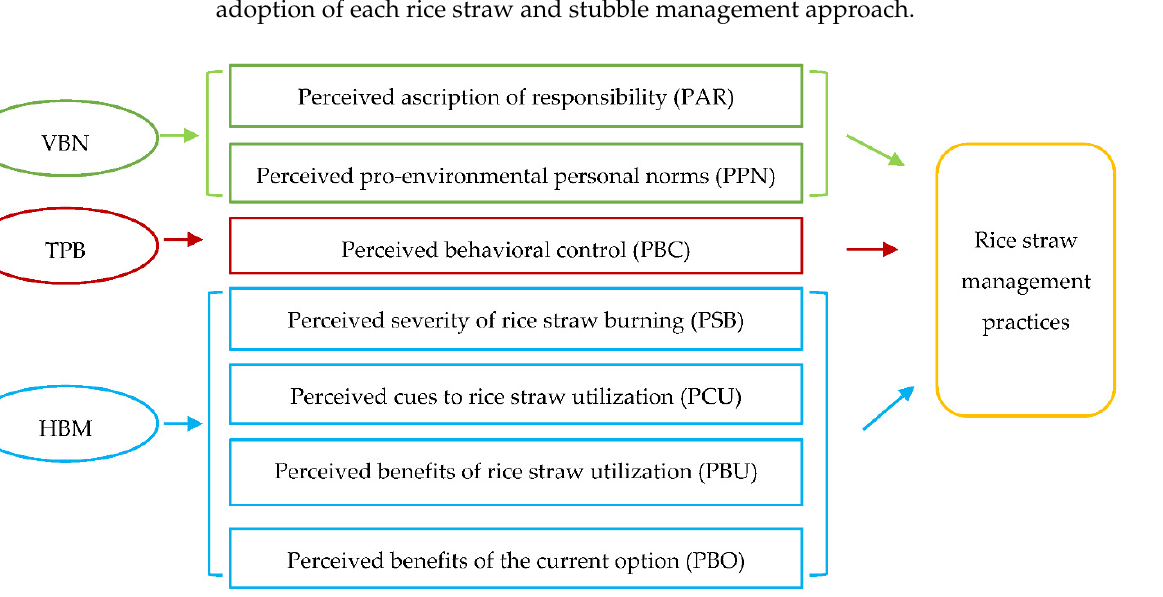
Figure 1. Integrated theories of TPB, VBN and HBM using in this study.